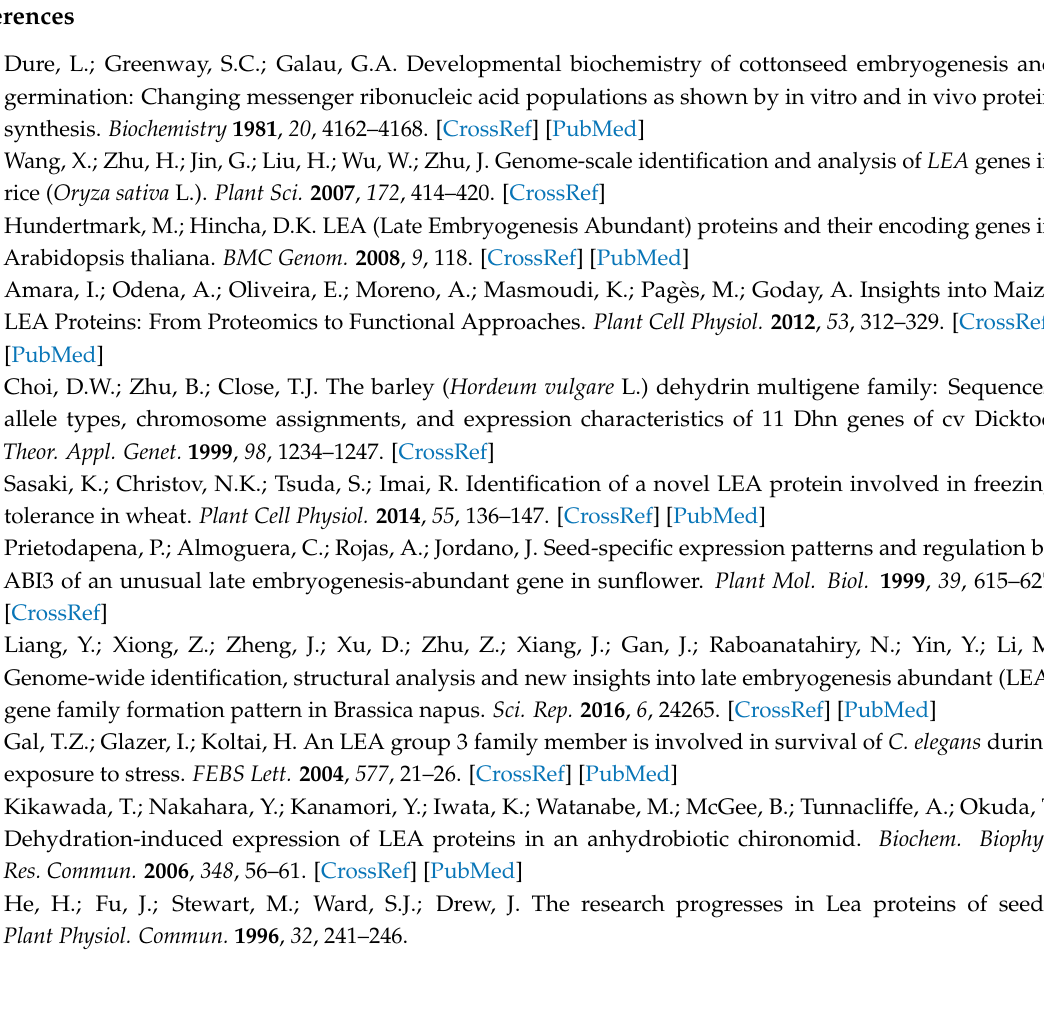
Table S2. The Ka / Ks ratios of duplicated LEA genes in cassava; Table S3. The expression profiles of the cassava LEA genes in different tissues; Table S4. The expression profiles (log2-based fold changes) of the cassava LEA genes after drought treatment; Table S5. Primers used in qRT-PCR